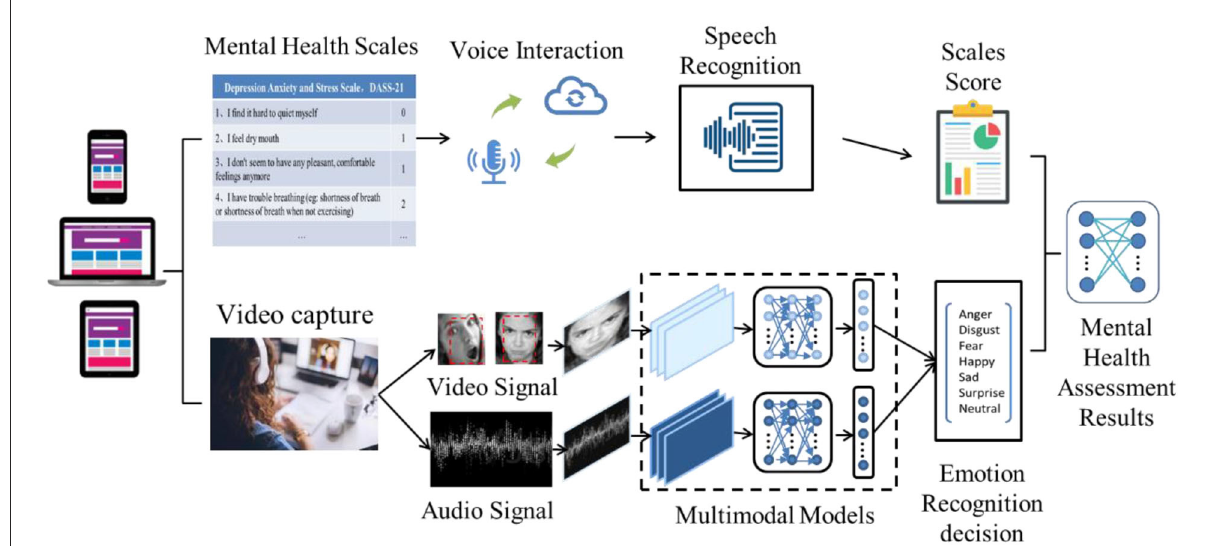
FIGURE1 Interactive multimodal emotion recognition scales system. The system includes two parts: an interactive questionnaire process and a multimodal emotion recognition